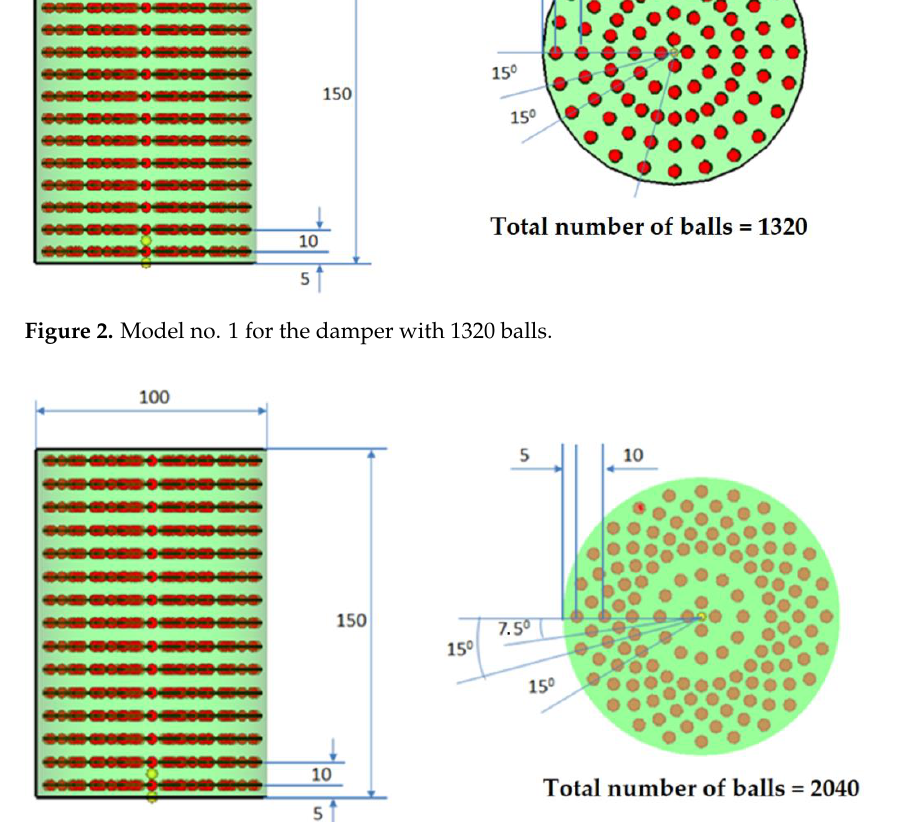
Table 1. The geometry of balls. N = 1320 balls.